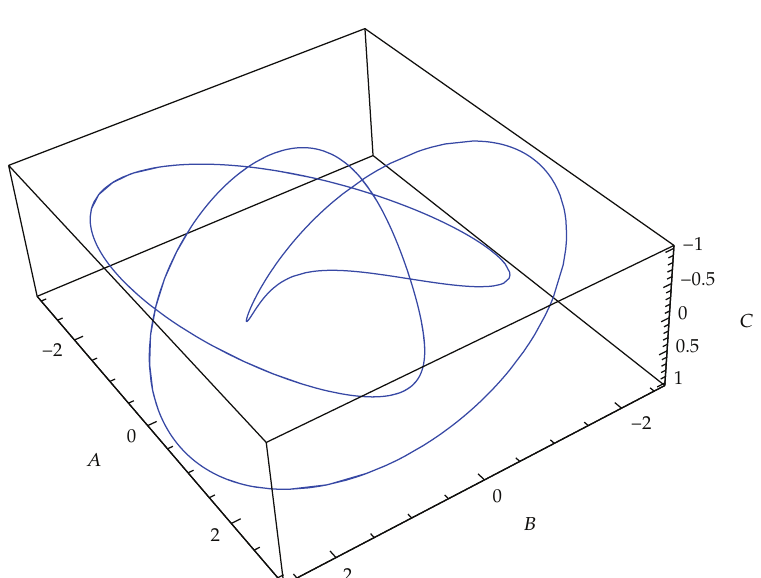
Figure 13: The figure-eight knot for (cid:2) 4.3 (cid:3) with (cid:2) 3.4 (cid:3) .